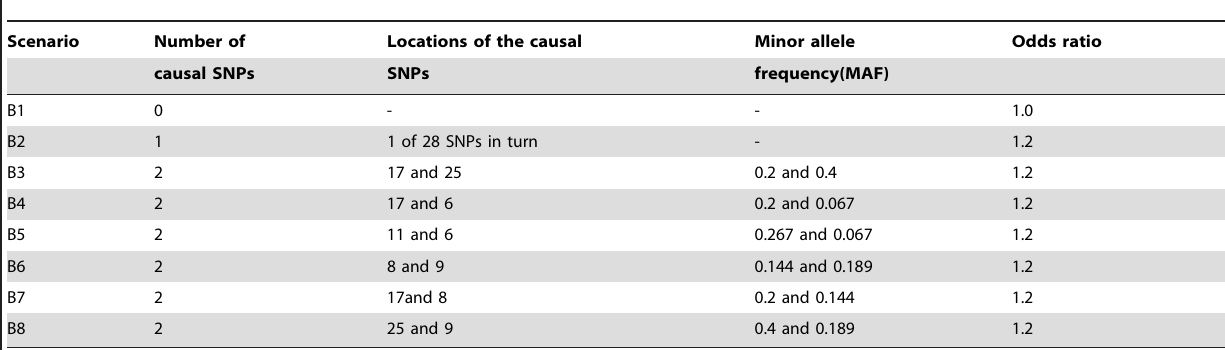
Table 2. Parameter settings of the CLPTM1L gene.